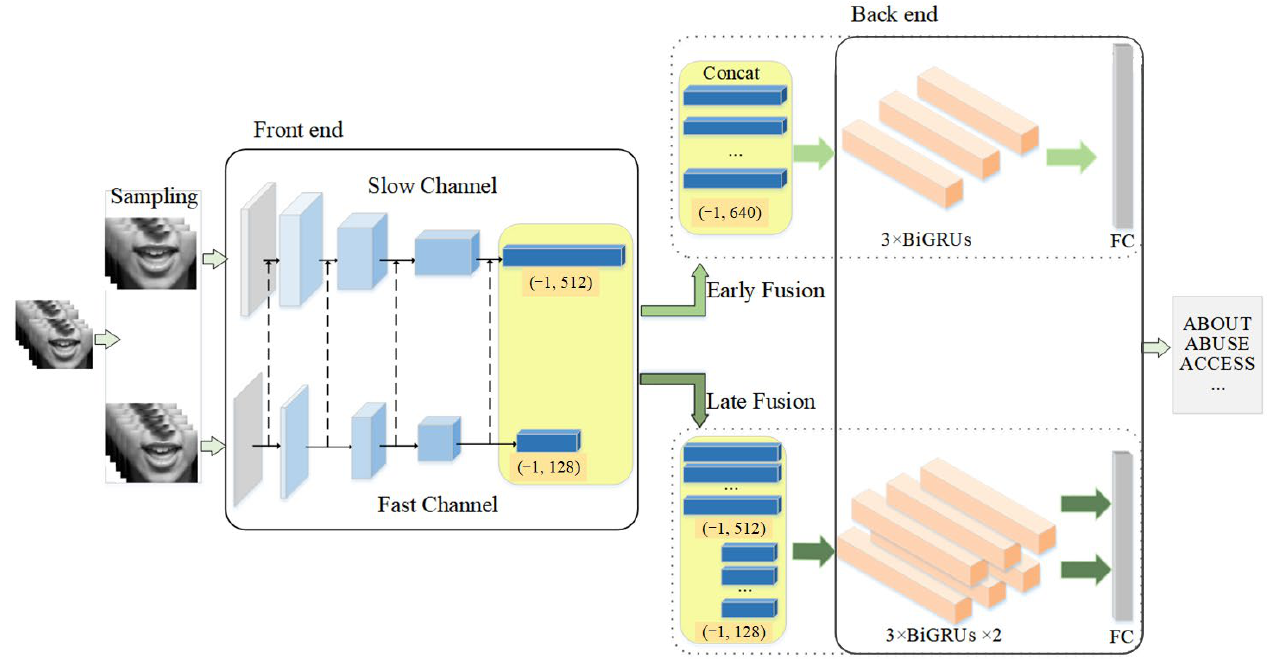
Figure 1. The overview of the Lip Slow-Fast (LSF). As shown in the picture above, the proposed model is a two-stream network. At first, the lip region sequence with different sampling intervals is input into two CNN streams; the above one is the slow channel, and the bottom one is the fast channel. The gray convolution is a shallow 3D CNN, and the others are 2D CNN. Then, the output feature vector will be input to the back-end model, which is a 3-layer Bi-Gated Recurrent Unit (BiGRU). In early fusion, the two feature vectors will concatenate together first and then do the sequence modeling; in late fusion, two feature vectors will send to the back-end model separately and concatenate together last. Finally, after a full connection layer, the model will predict the result of the input lip sequence.